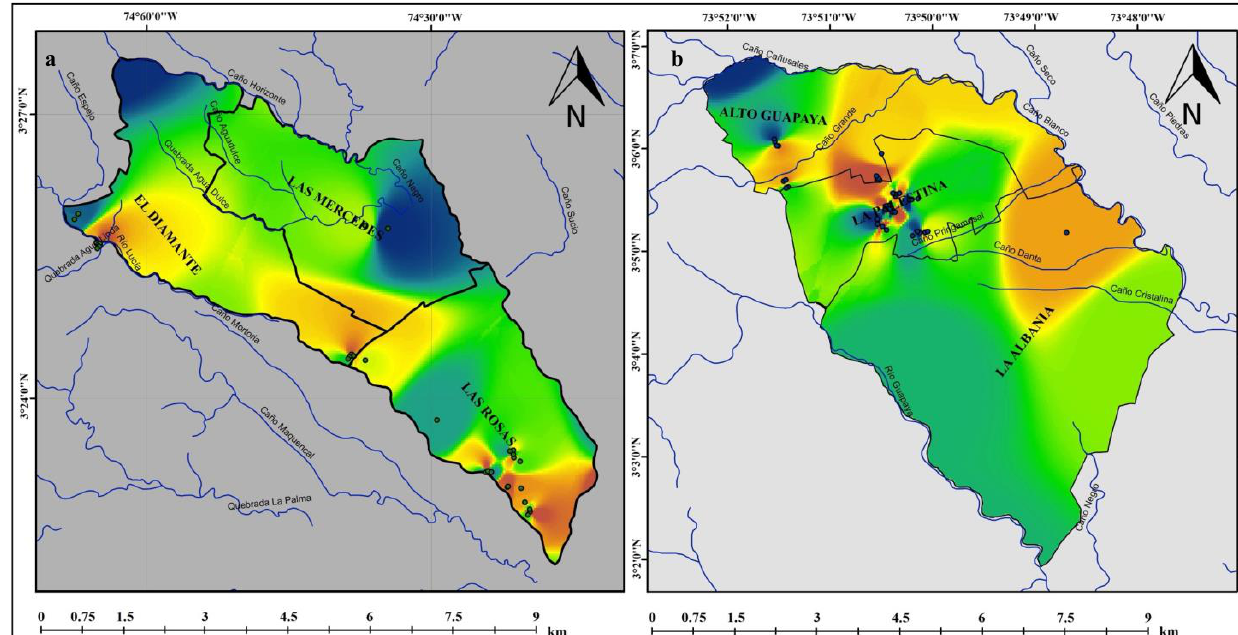
Figure 5. Map of the sensory distribution of cocoa in the municipalities of Mesetas ( a ) and Vista Hermosa ( b ). Blue to red indicates highest to lowest cocoa bean quality.